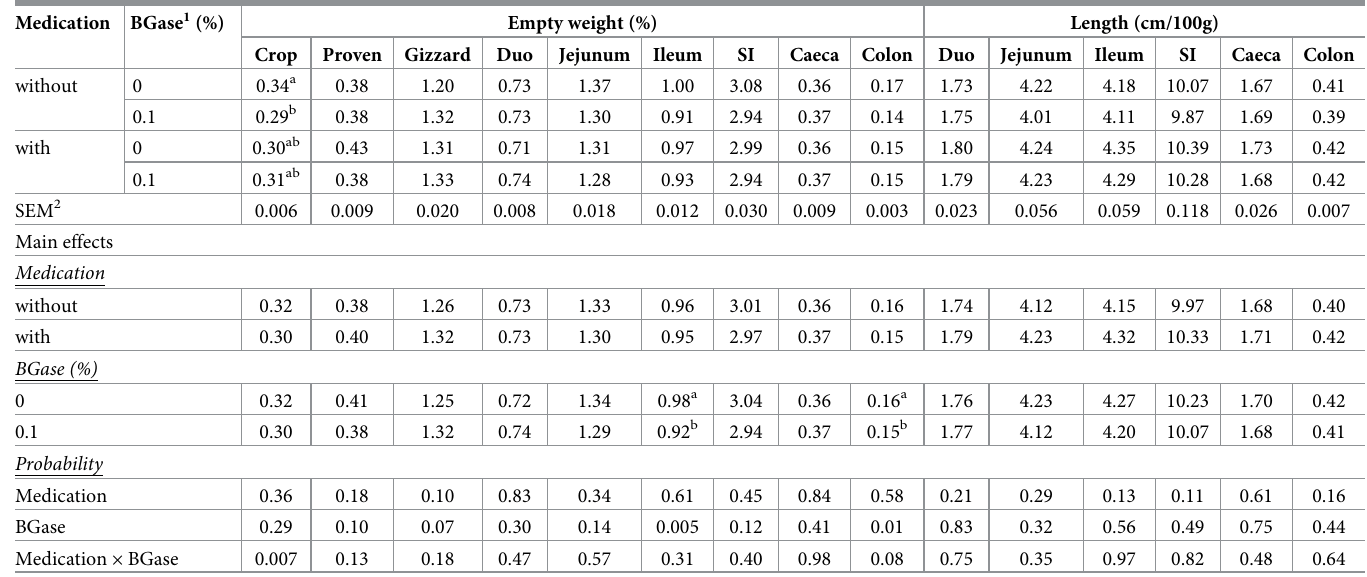
Table 7. Effects of diet medication and β -glucanase on gastro-intestinal tissue weights and lengths (proportional to body weight) of broiler chickens at d 28 (Experi- ment 1). Medication BGase 1